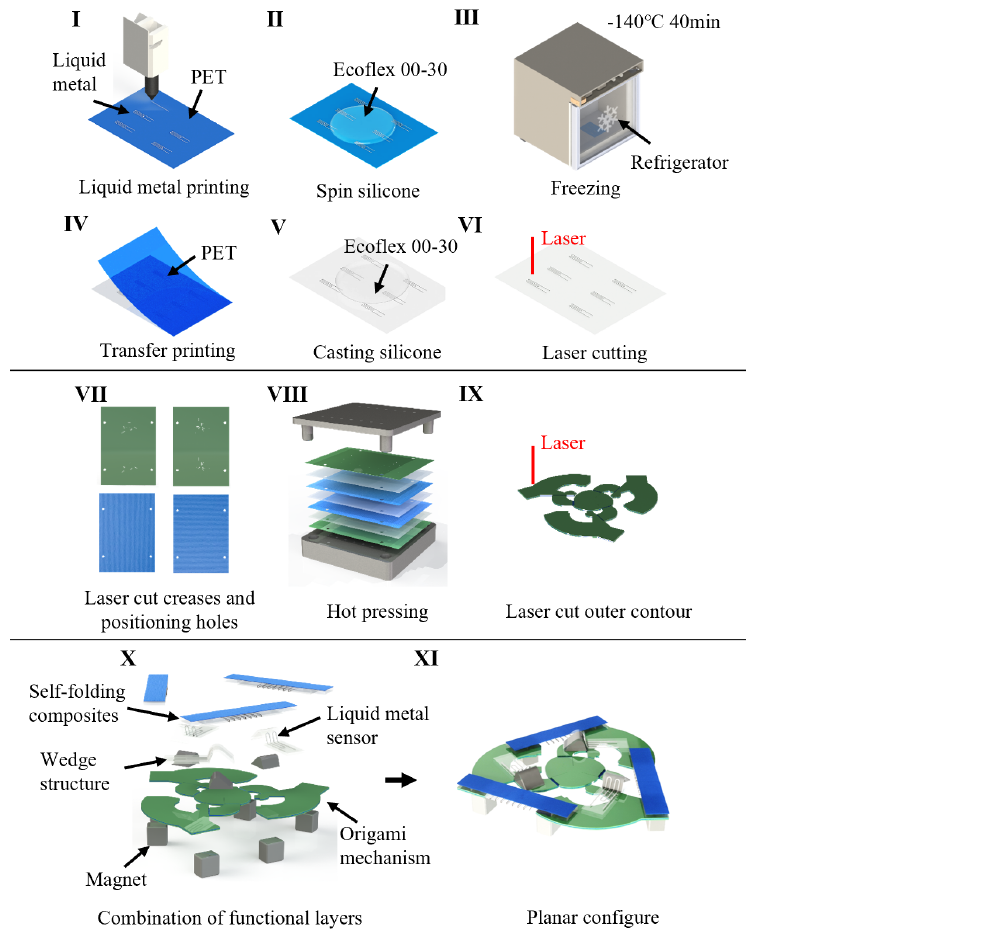
Figure 3. Fabrication process of the miniature soft sensor. I–VI shows the fabrication of liquid metal sensors. VII–IX shows the fabrication of the micro origami mechanism. X–XI shows the combination of each functional layer and forming of the overall